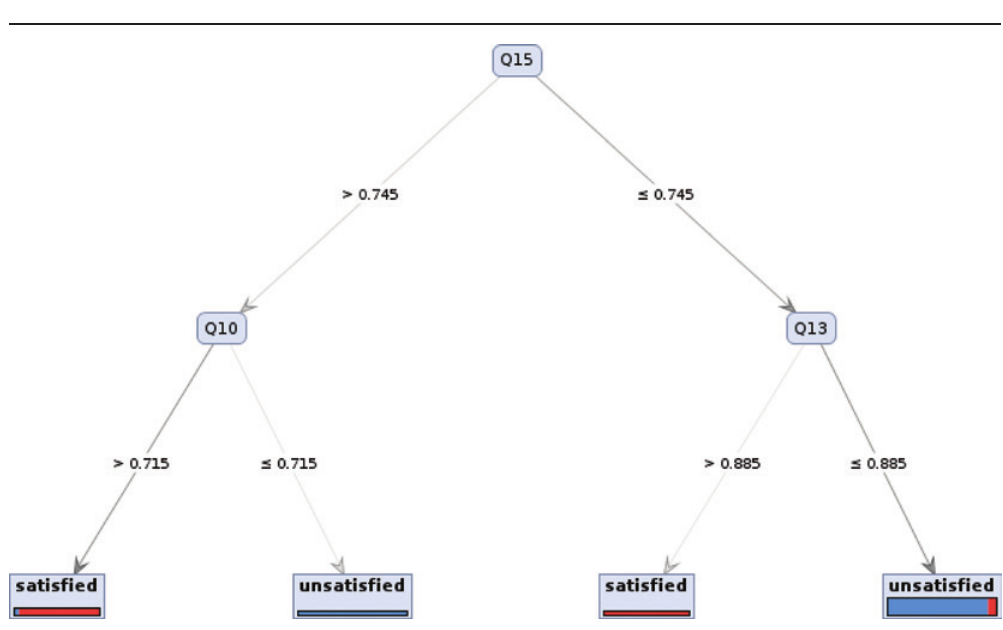
Figure 10: AI-generated tree model showing how Q22 satisfaction can be predicted from other NSS questions, in computer science, for Russell Group